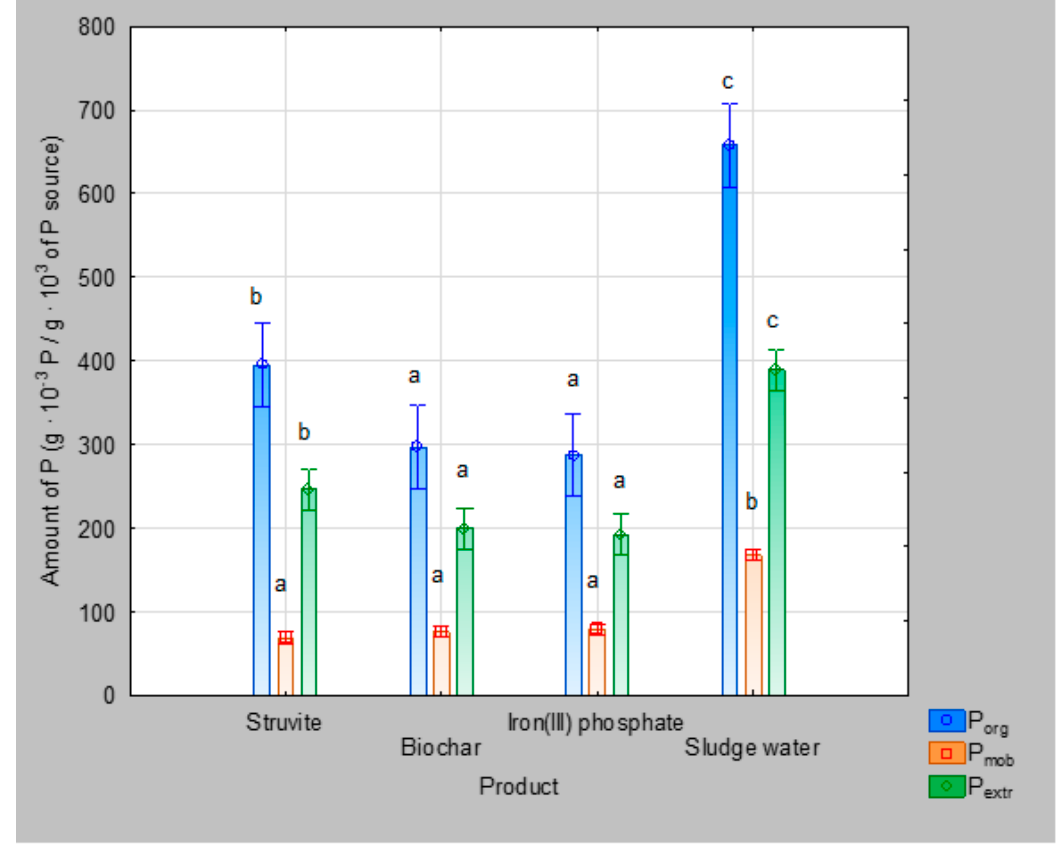
Figure 3. Phosphorus in Haplic Cambisol soil after addition of 6.2 × 10 − 3 g of P (in phosphorus source)/g of soil (Mehlich II). Vertical bars denote 0.95 confidence intervals. Significant differences